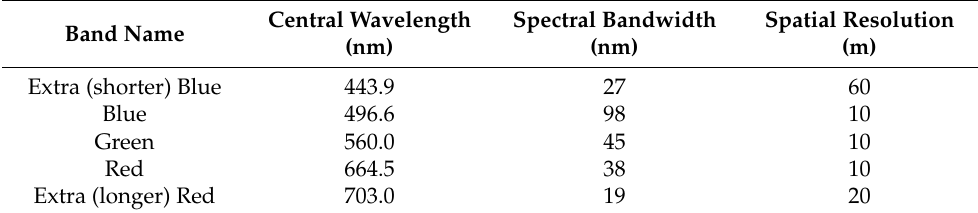
Table 1. Sentinel-2 spectral and spatial